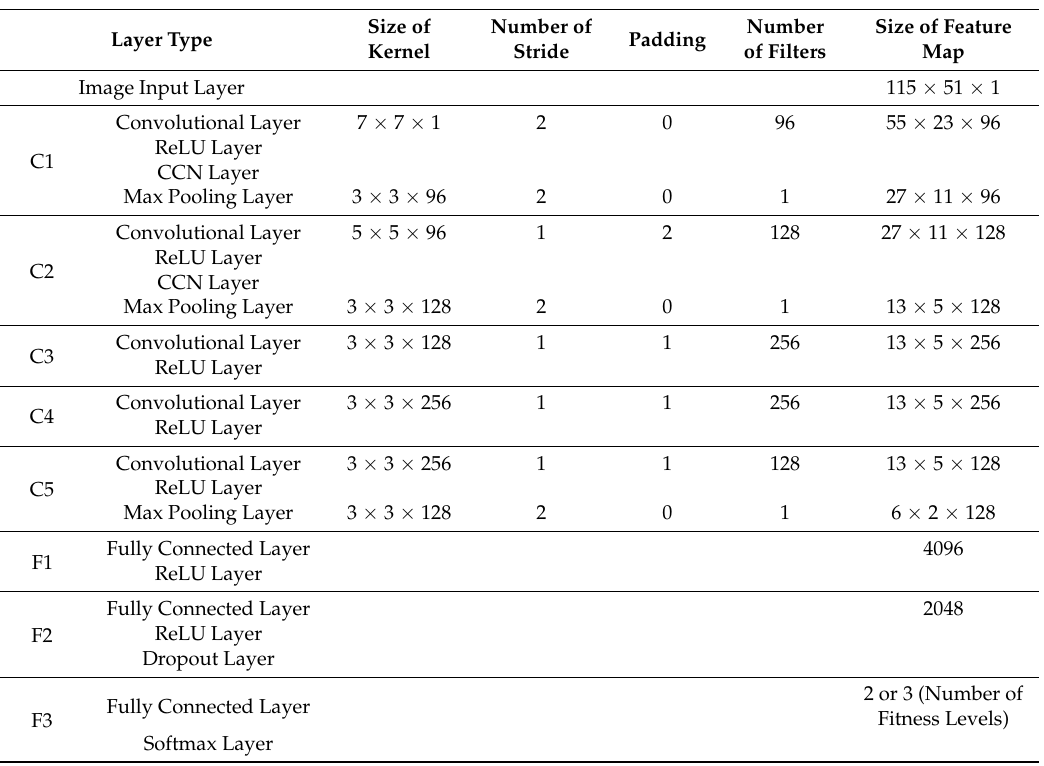
Table 2. Structure of CNN used in our proposed method (unit: